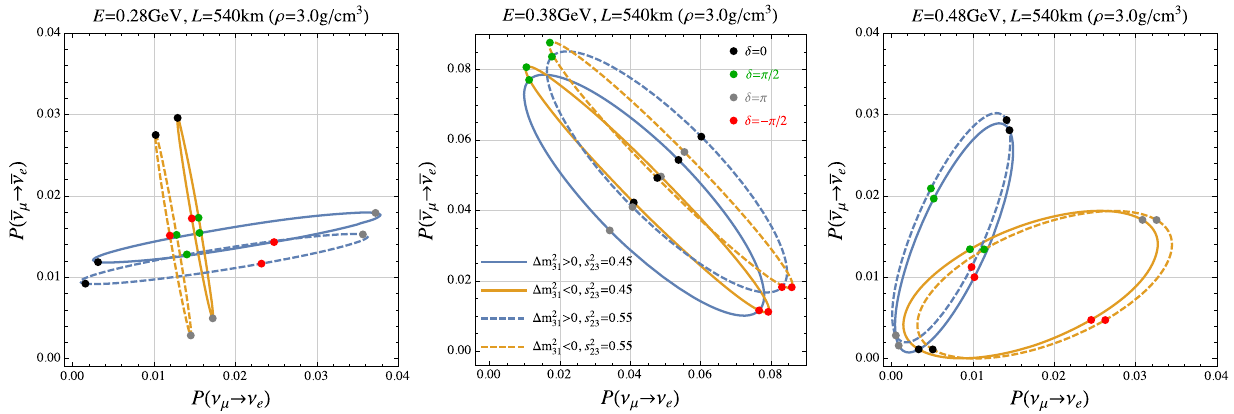
Fig. 2 Bi-probabilityplotsfortheESS-Garpenbergsetup L = 540km. orangesolidfor(0 . 45 , − ),bluedashedfor(0 . 55 , + ),andorangedashed Three plots for three different neutrino energies: E = { 280 , 380 , 480 } for (0 . 55 , − ). The energies E = 380 MeV and E = 480 MeV corre- MeV from left to right. The four ellipses in each plot for the differ- spond to the vicinity of the second oscillation maximum and the first ≡ sin 2 θ (cid:7) m 2 ent choices of ( s 2 ]): blue solid for (0 . 45 , + ), oscillation 23 , sign[ 23 31